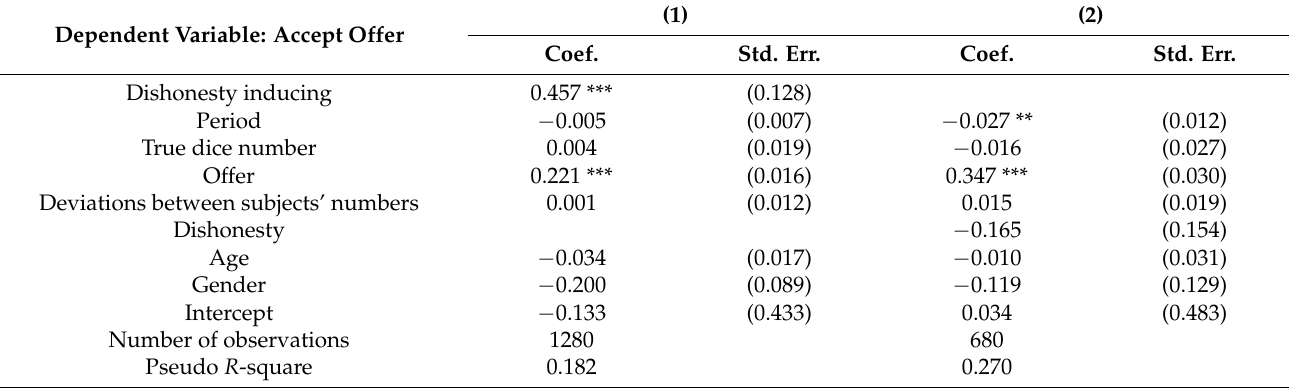
Table 4. Probit regression on receivers’